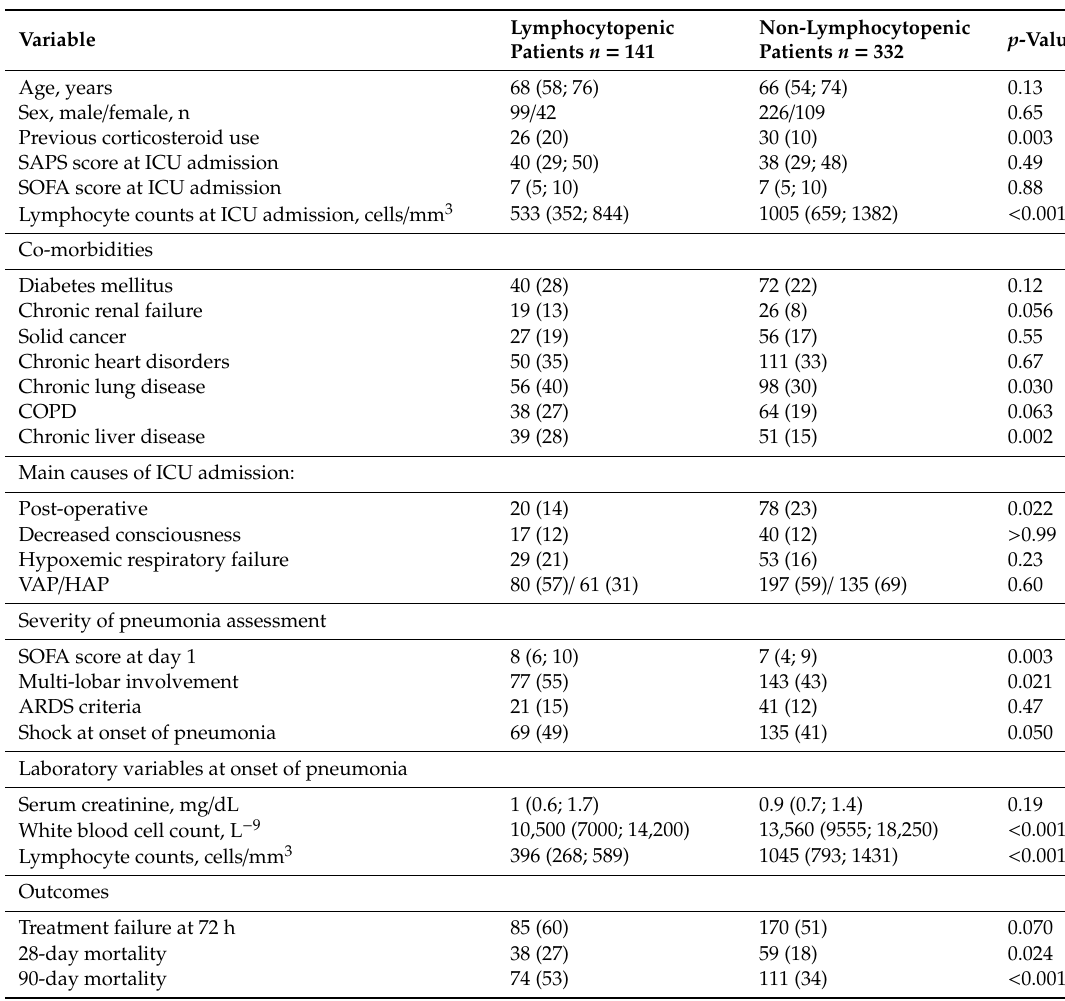
Table 1. Patients’ clinical characteristics and outcomes.